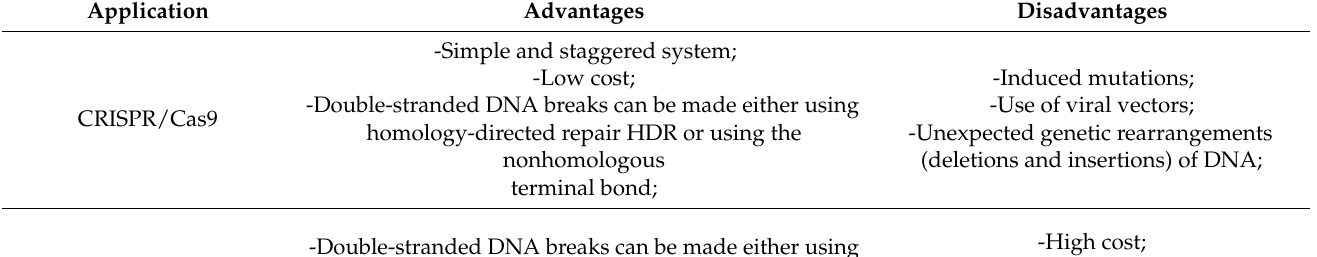
Table 1. Comparison of the advantages and disadvantages of clustered regularly interspaced short palindromic repeats (CRISPR)/Cas- 9, ZNF, and transcription activator-like effector nucleases (TALEN) gene